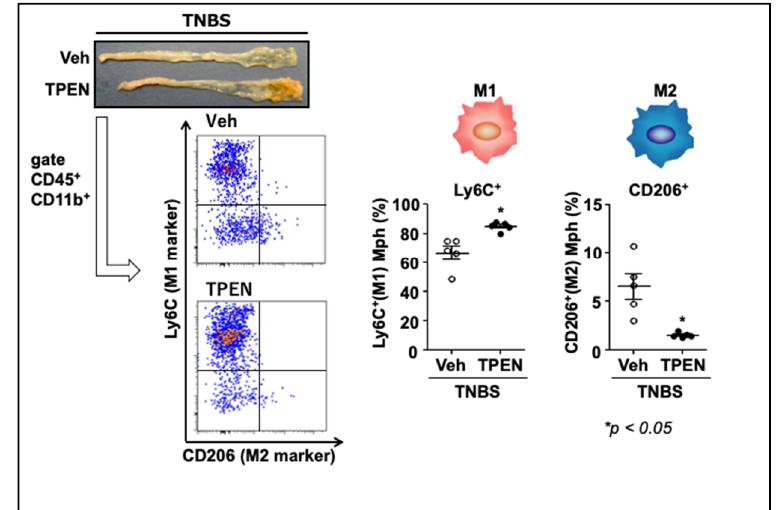
Figure 4. Effects of zinc deficiency on the macrophage phenotype under inflammatory conditions. Proportions of Ly6C + macrophages (M1) and CD206 + macrophages (M2) in colonic lamina propria mononuclear cells (LPMCs) as determined by flow cytometry. Veh; vehicle treated group, TPEN; N,N,N (cid:48) ,N (cid:48) -tetrakis(2-pyridylmethyl)ethylenediamine (TPEN)-treated group. The data are